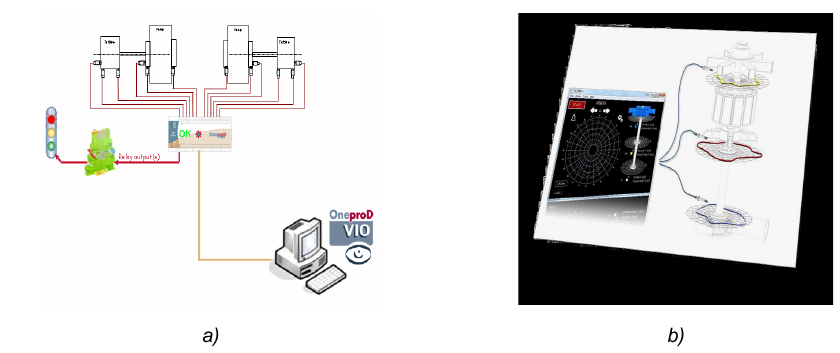
Figure 21 – On-line monitoring system and the monitoring system for sliding bearings Рисунок 21 – Изображение онлайн системы мониторинга и системы мониторинга по подшипникам скольжения Слика 21 – Приказ on-line мониторинг система и мониторинг система за клизне